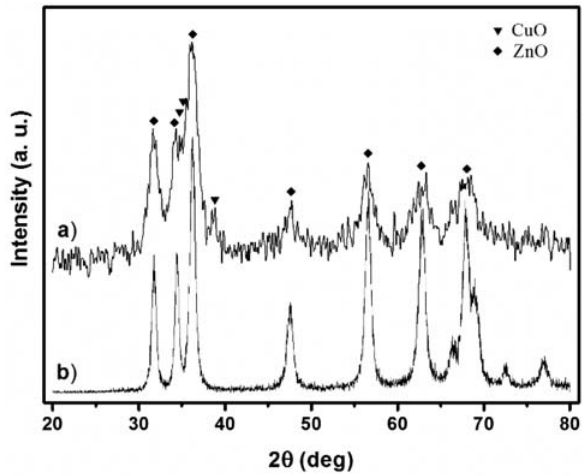
Figure 1. XRD patterns of (a) ZnO, and (b) 20CuO/ZnO nanoca- Table 1: Structural properties of prepared samples.